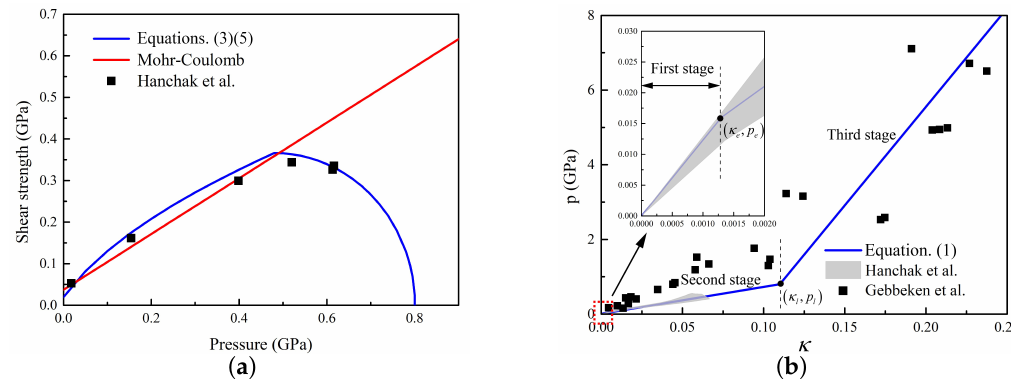
Figure 4. Experimental data and calibrated constitutive laws: ( a ) yield criterion[11,39]; and ( b ) equation of state